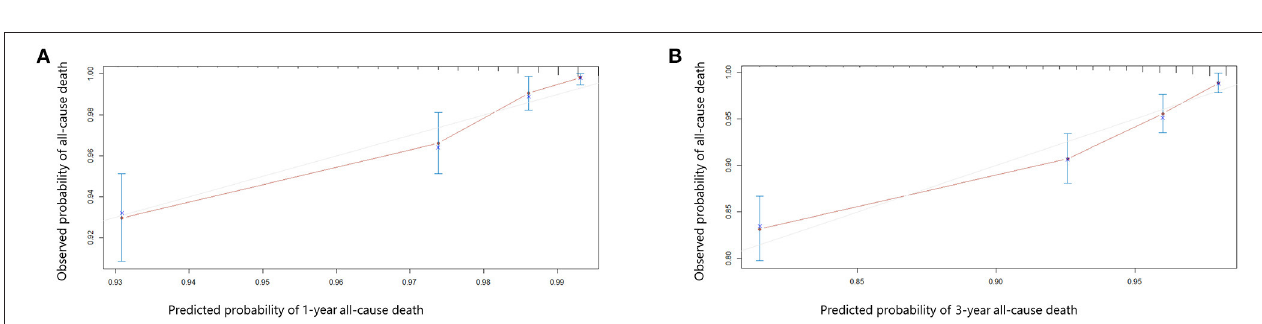
FIGURE 3 | Calibration curves showing the probability of 1- year (A) and 3-year (B) all-cause death between the nomogram prediction and the actual observation.